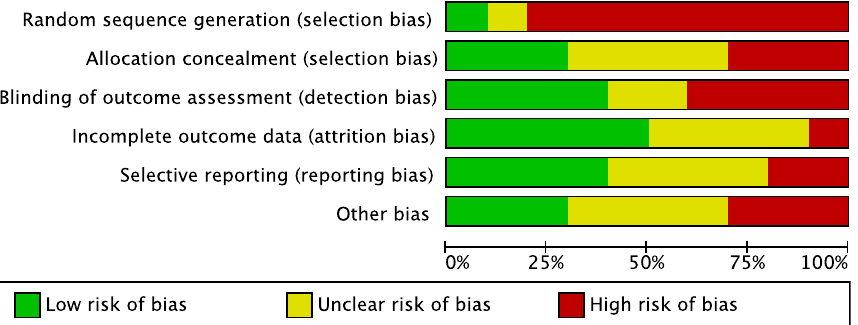
Figure 2. Cochrane risk of bias tool. The risk of selection bias analysed the random sequence generation and the allocation concealment. The risk of detection bias in the blinding procedure during the outcome assessment were analysed. The risk of attrition bias refers to incomplete outcome data, such as missing outcome data from attrition during study enrollment or analysis. The risk of reporting bias refers to the selective publication of